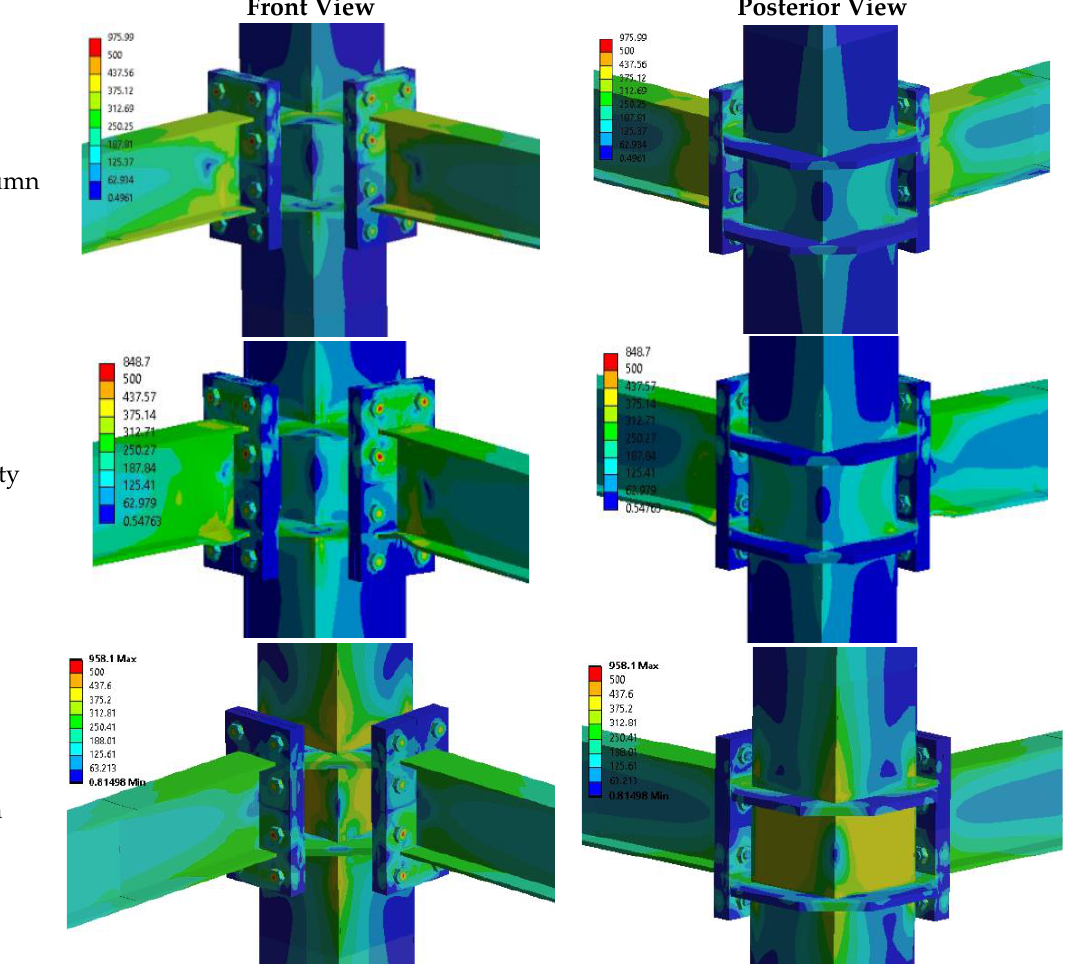
Figure 10. Stress distribution in the 2BC models (Units: MPa) .